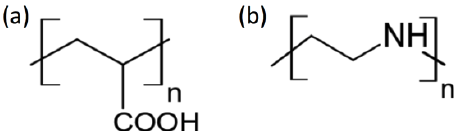
Figure 1. Polymeric additives in the present study: ( a ) poly(acrylic acid) (PAA); ( b ) poly(ethylene imine) (PEI).